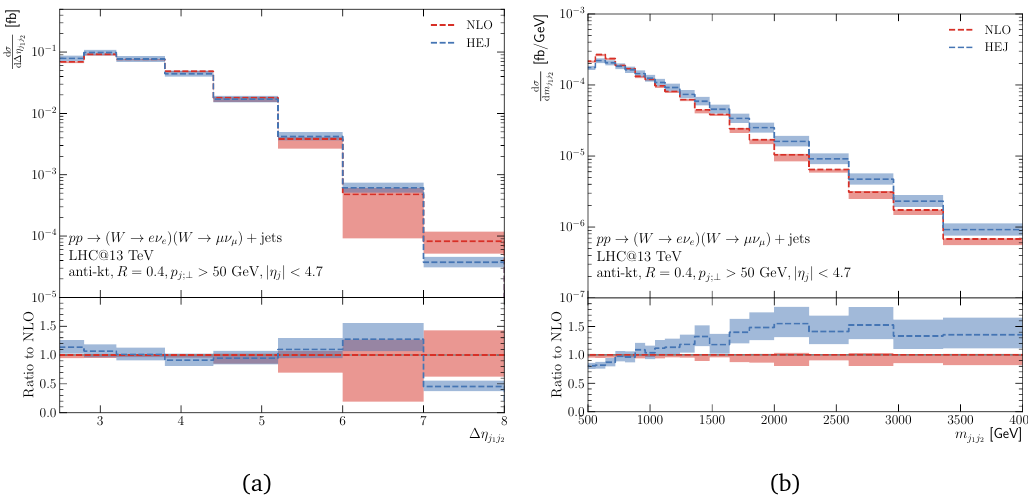
Figure 3: Differential distributions in the pseudorapidity separation (a) and invariant mass (b) of the two leading